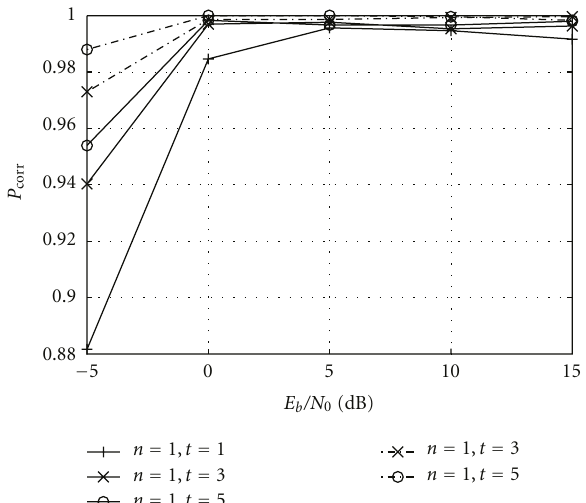
Figure 10: Probability of correct detection P corr versus observation time T obs for di ff erent multiple antenna CR terminal with a variable number t of antennas for the extracted features (continuous lines) and for the SCF profile (dotted